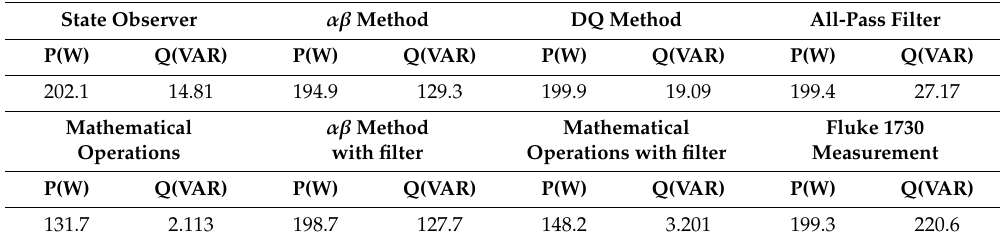
Table 4. Experimental measurements—non-linear load.